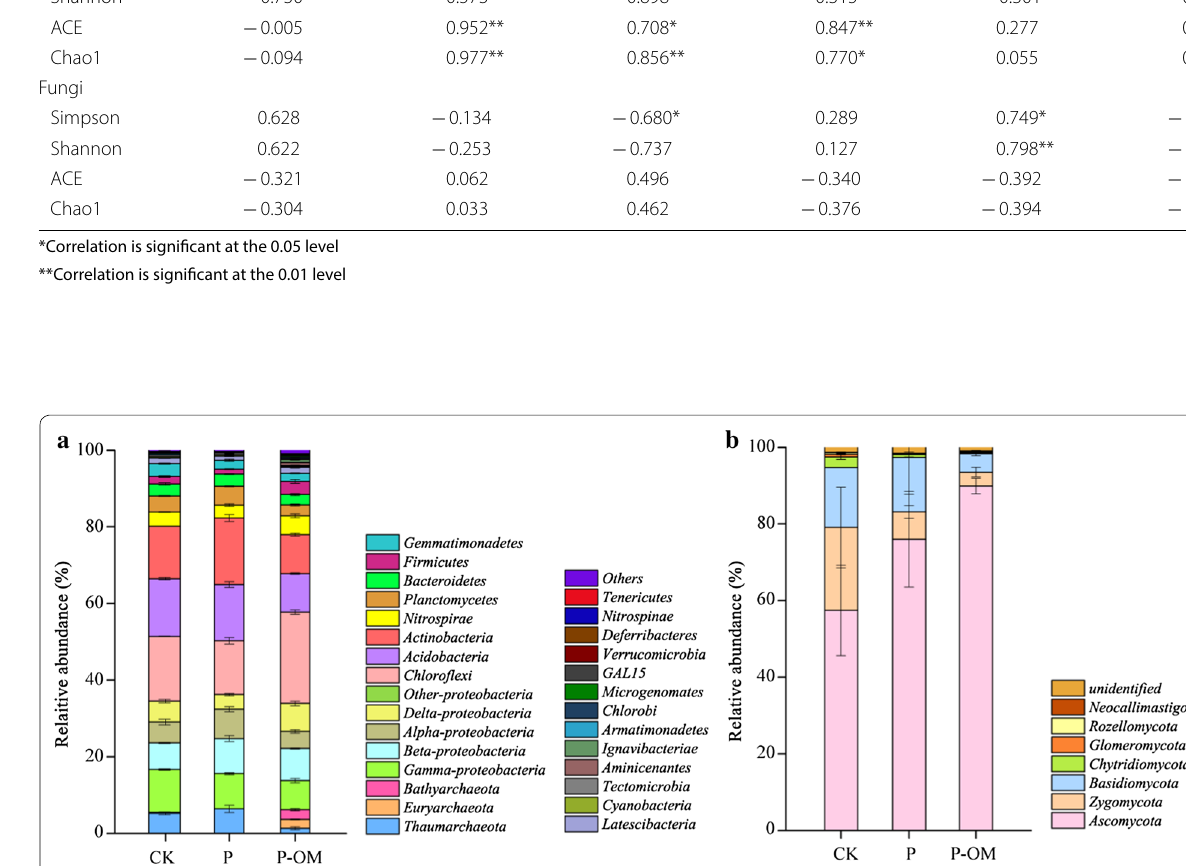
Fig. 3 Community composition of bacteria ( a ) and fungi ( b ) in phylum level. Only Proteobacteria phylum was displayed in class level. The relative abundances are the average of the triplicate Miseq sequencing data